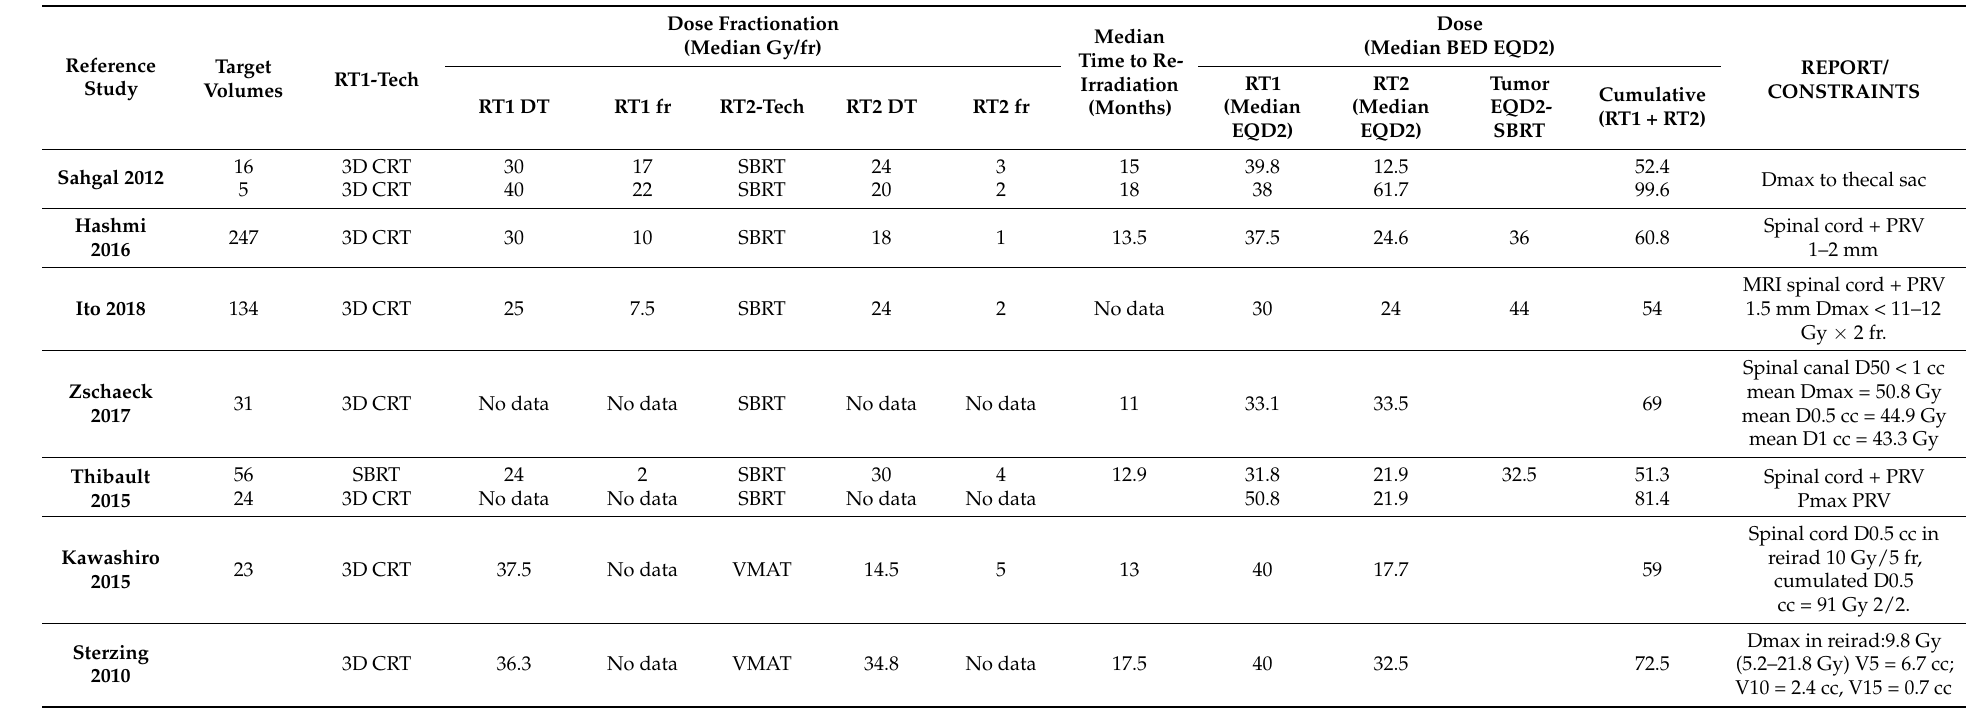
Table 3. Anatomical reference points for dose reporting in selected